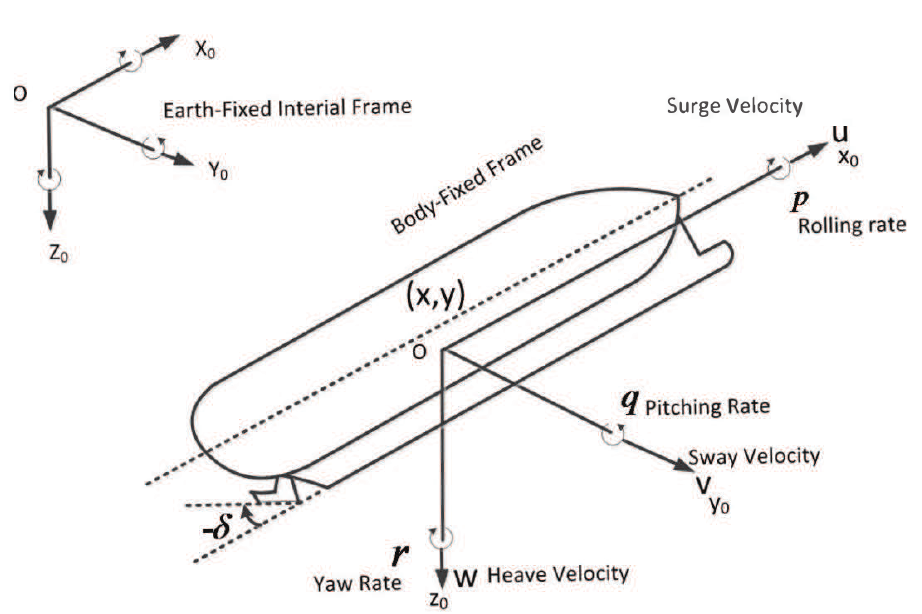
Figure 1. The earth-fixed inertial and body-fixed